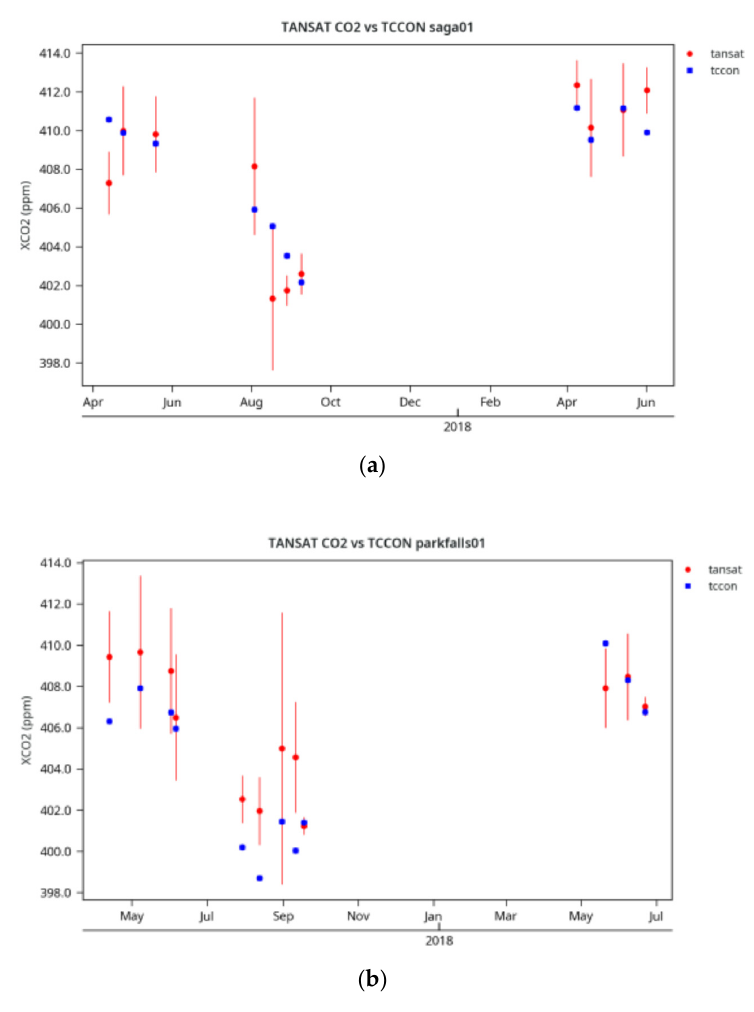
Figure 1. Time variation of XCO 2 retrieved from TanSat nadir observations over land (red dots) and collocated TCCON measurements (blue dots) for the stations of ( a ) Saga and ( b ) Parkfalls. SD of the TanSat retrievals are presented with the length of bar. All the retrievals shown here are bias-corrected.